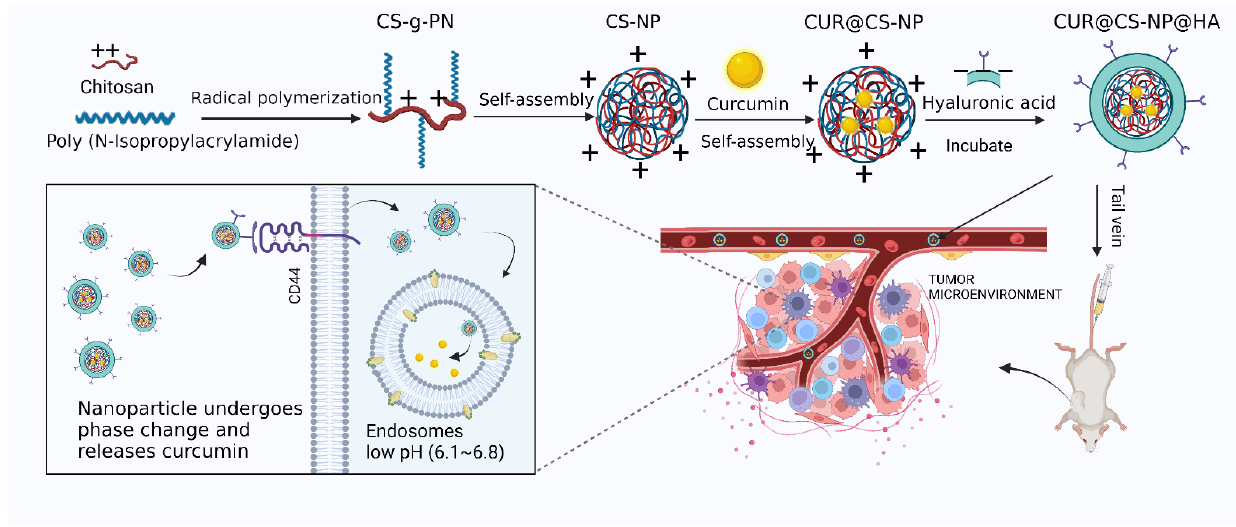
Figure 1. Schematic diagram of NP synthesis and release mechanism.